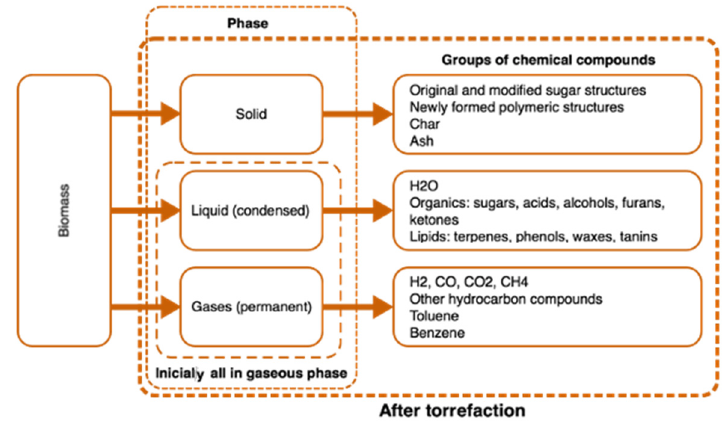
Figure 6. Main constituent compounds of each of the fractions formed during the torrefaction process.